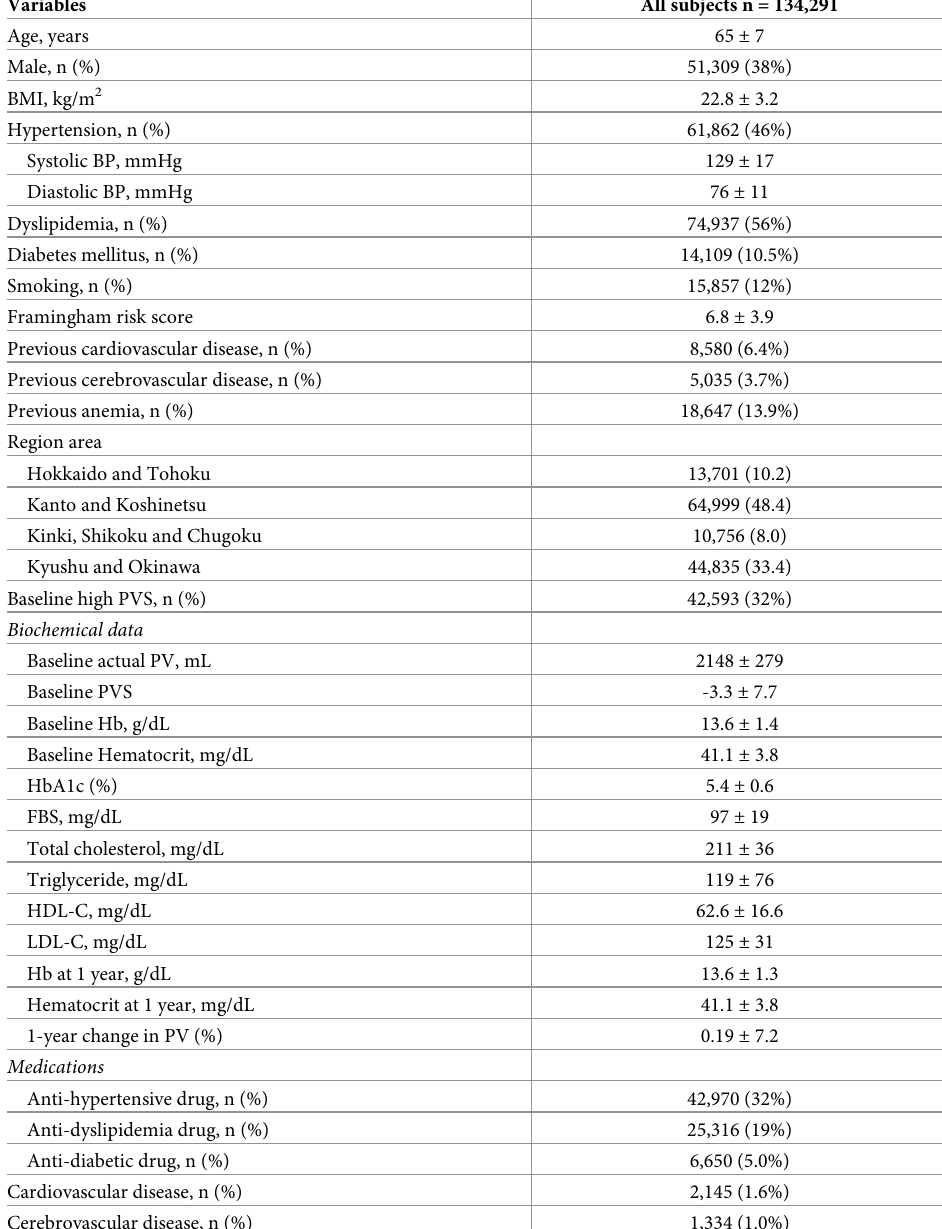
Table 1. Baseline clinical characteristics in all